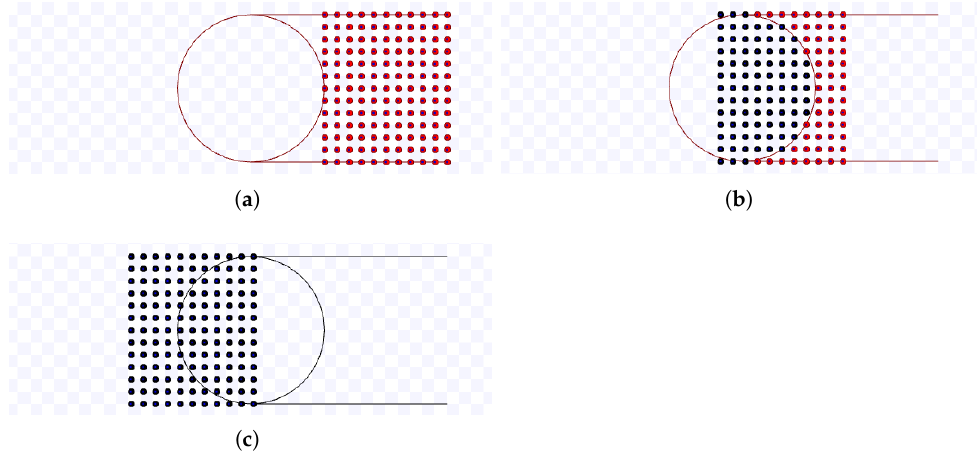
Figure 24. Simulation on Stage for parallel lanes strategy using s = 6 m, d = 1 m during T = 16 s. Available on https://youtu.be/TVdka65fi1g, accessed on 12 June 2022. ( a ) 0 s: beginning of the simulation; ( b ) After 8 s; ( c ) 16 s: ending of the simulation.